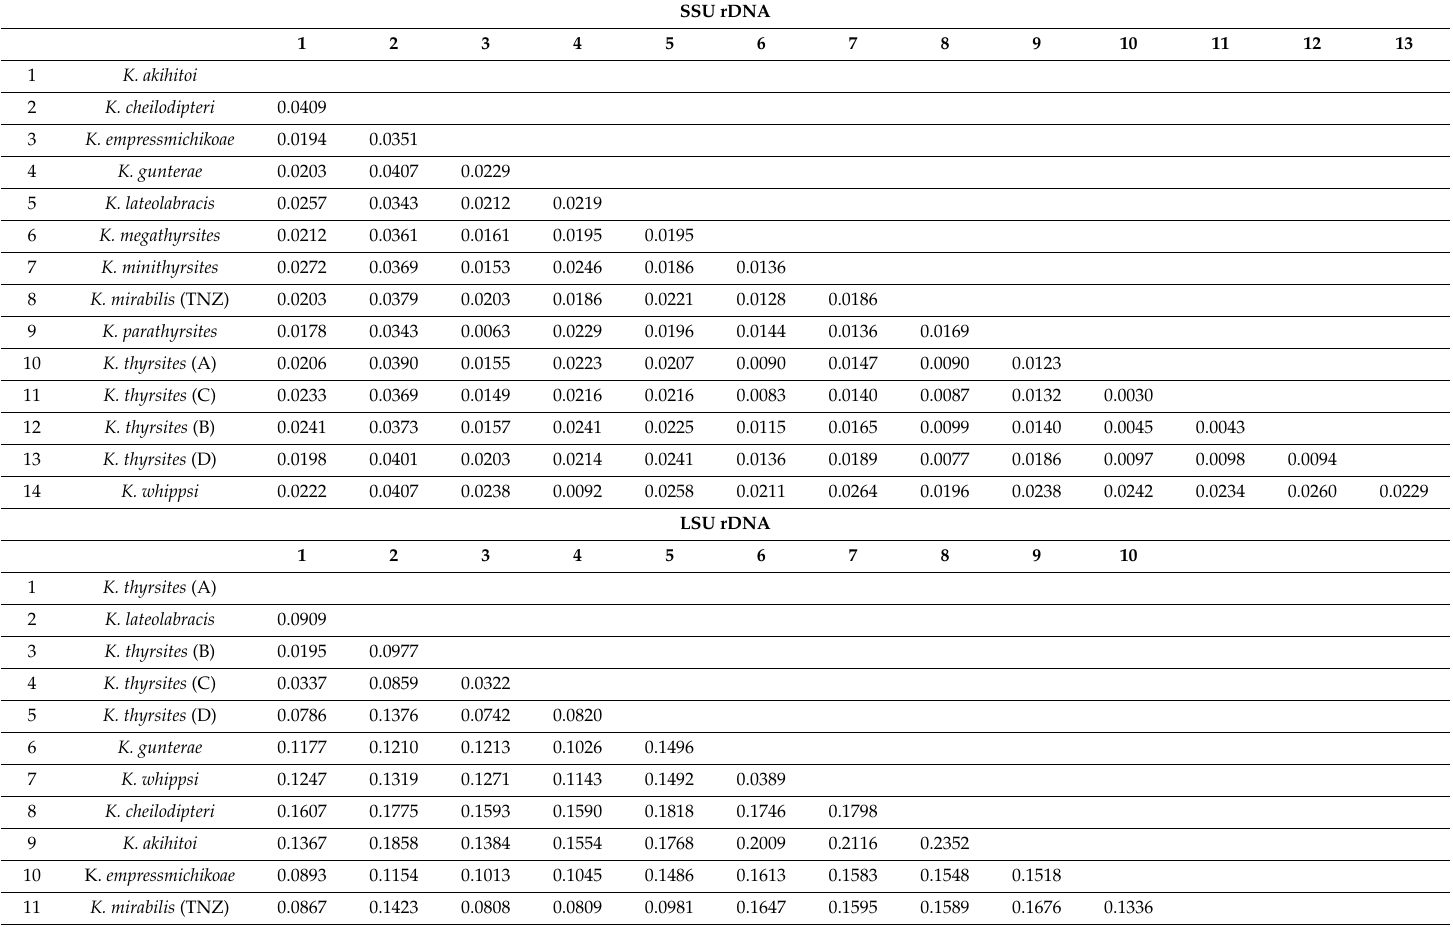
Table 2. Genetic divergences over comparable size sequence pairs of the SSU and LSU rDNA between Kudoa mirabilis and phylogenetically closely related taxa. Each taxon included all the Kudoa corresponding sequences shown in the trees (Figure 4A,B). According to the existence of four geographical strains of K thyrsites , its relative sequences were assigned to four corresponding groups: Atlantic Ocean (A), Pacific Ocean (B), Australian waters (C), and Japanese (plus one sequence from South Africa, exceptionally present here) (D). Each group contained all the corresponding sequences reported in the